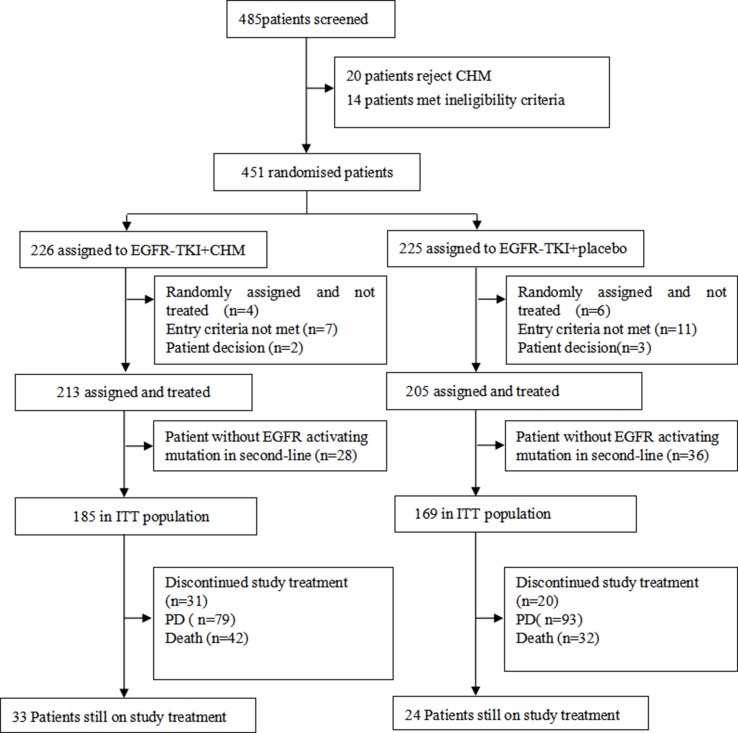
CONSORT diagram: trial profile at the cut-off date for analysis (January 5, 2018) PD, progressive disease.